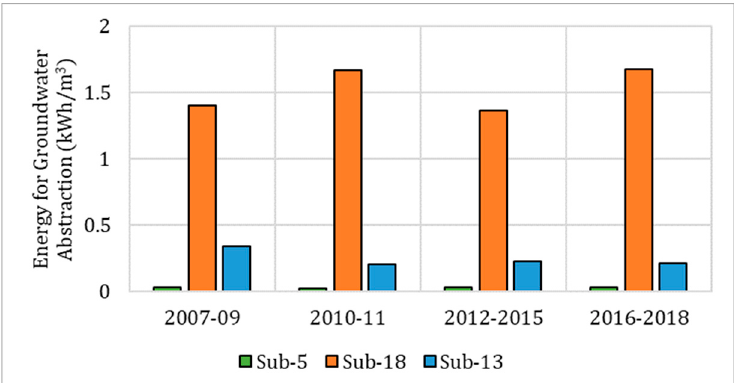
/ m 3 ) in three study